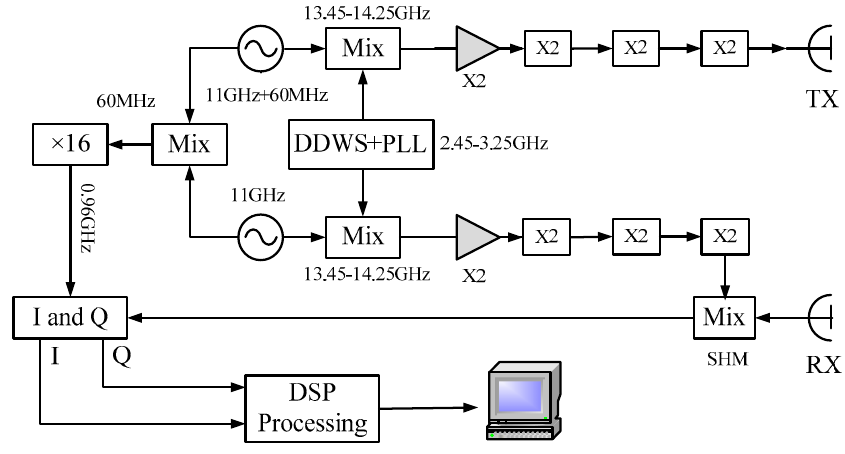
Figure 2. Schematic diagram of the 0.22 THz radar system.